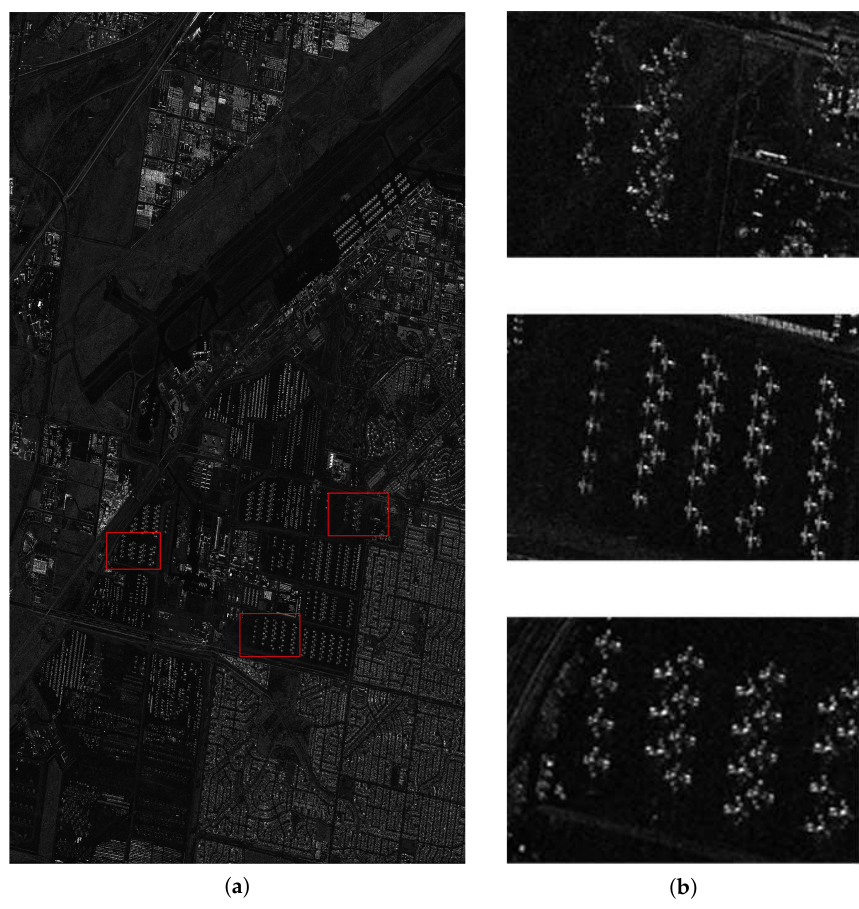
Figure 3. Davis–Monthan data set. ( a ) an overview of Davis–Monthan data set; ( b ) three sampling areas in